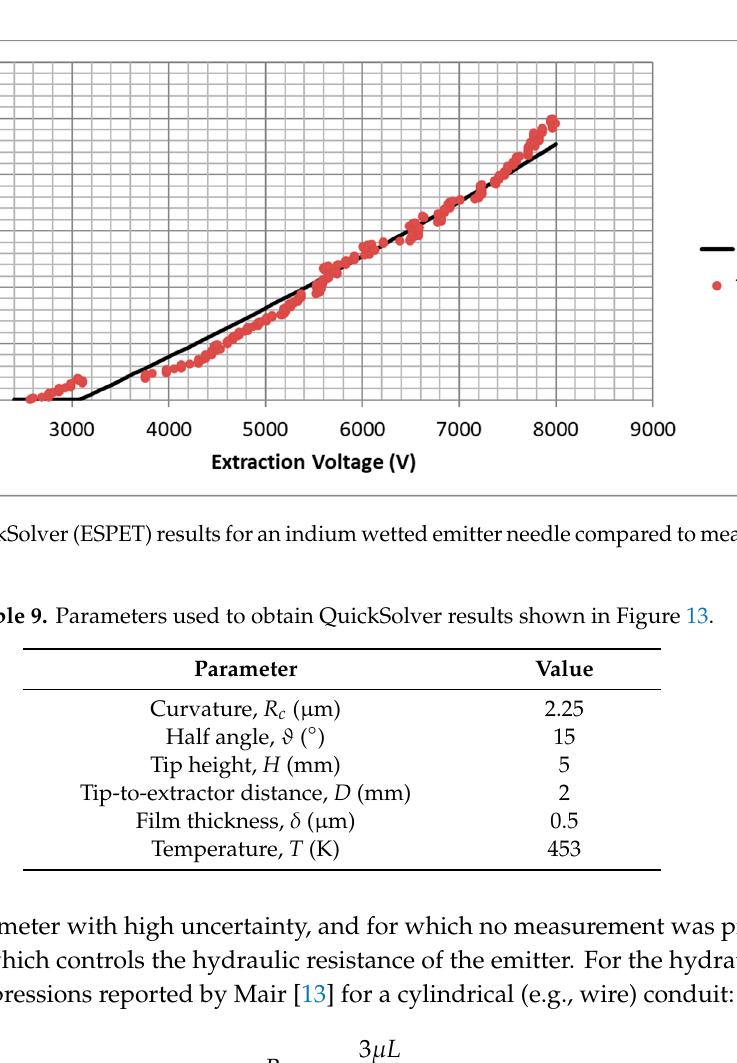
Figure 16. Mass efficiency versus extraction voltage computed by QuickSolver for an indium wetted emitter tested by Tajmar [14].